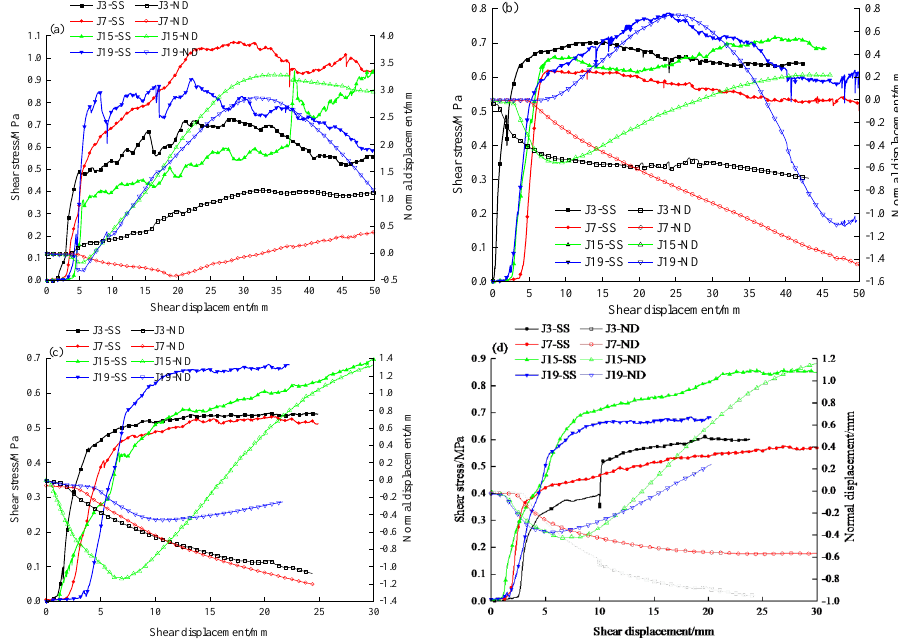
Fig.4. SS and ND versus SD curves under normal stress of 1.0 MPa: (a) without filling; (b) semi-solid soil; (c) plasticized soil; and (d) liquid soil.